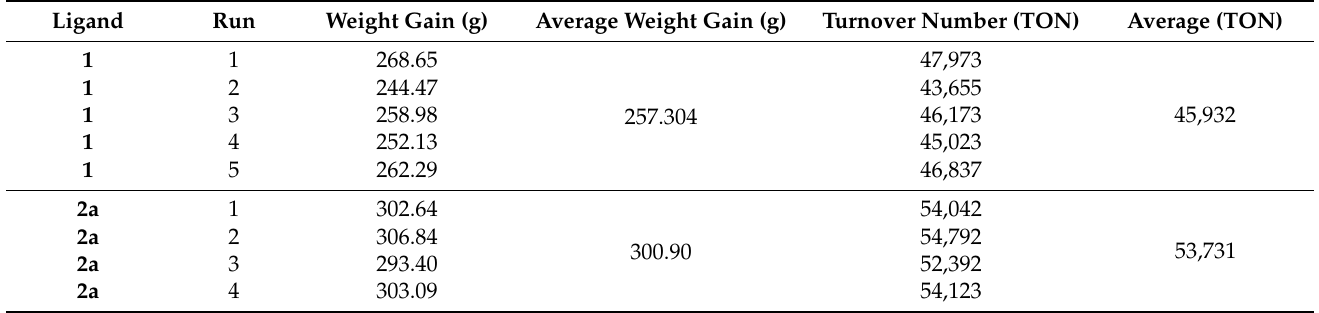
Table 2. The methoxycarbonylation of ethene using the alpha ligand, 1 , and butphos , 2a